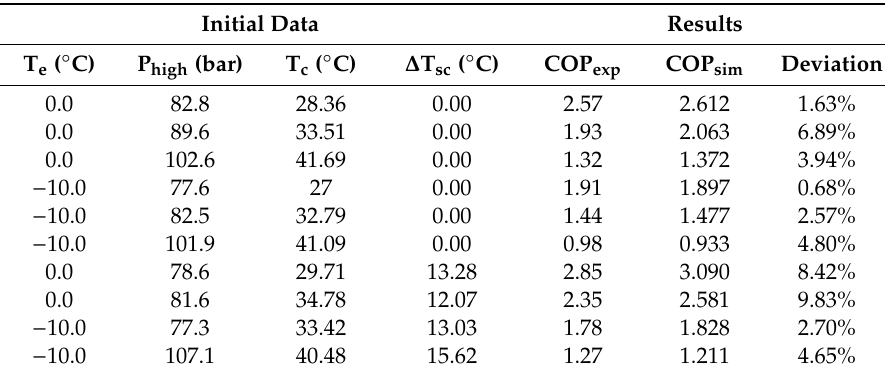
Table 1. Checking the model validity using data from